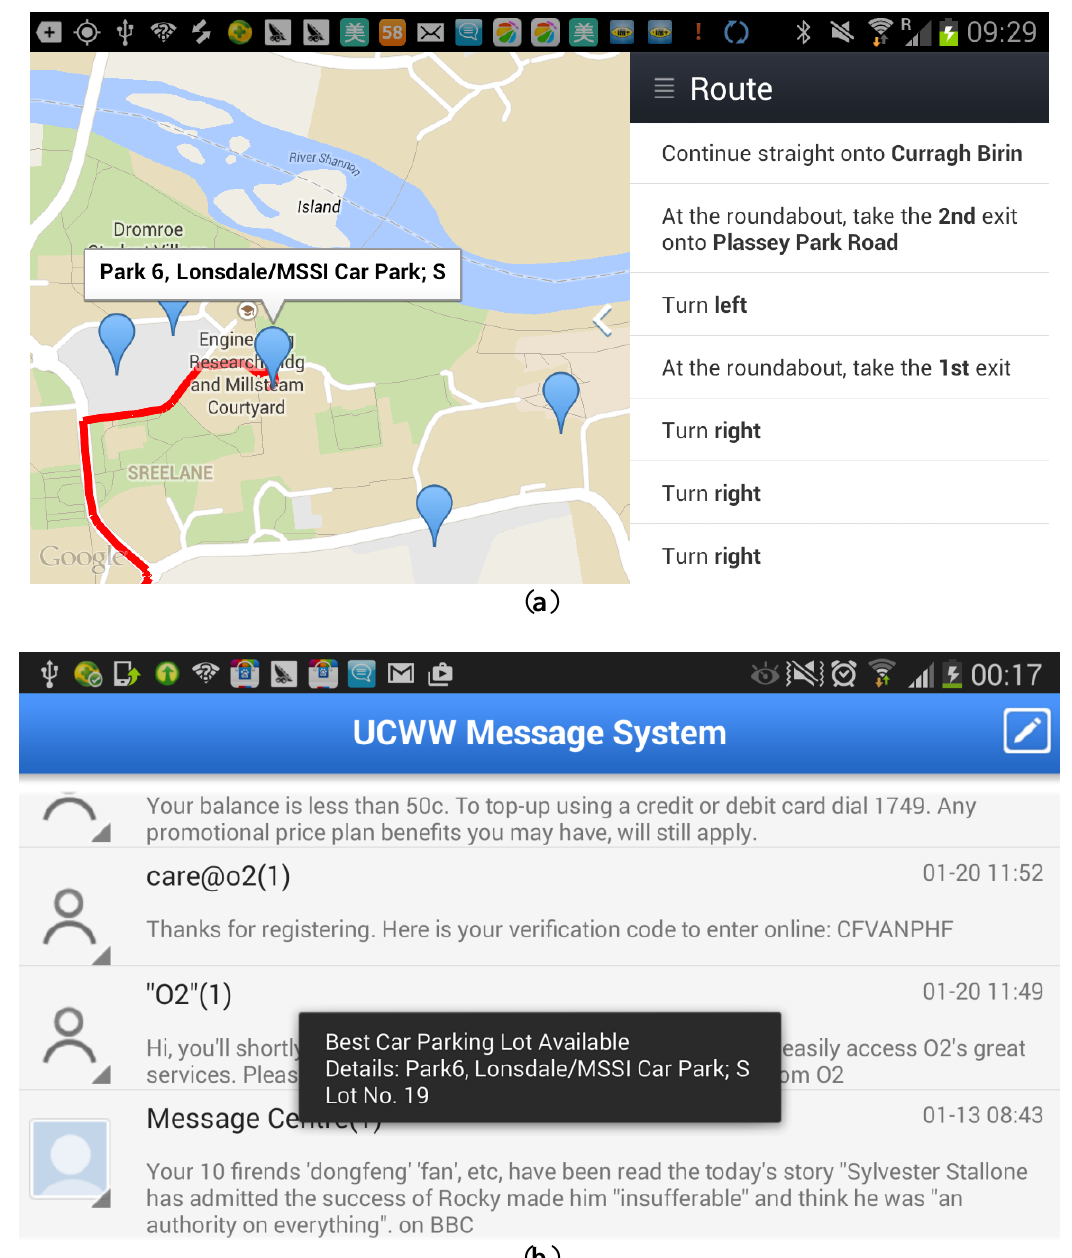
Figure 20. The Car Parking Android Mobile App for navigation: ( a ) for GPS-enabled mobile devices; ( b ) for non-GPS-enabled mobile